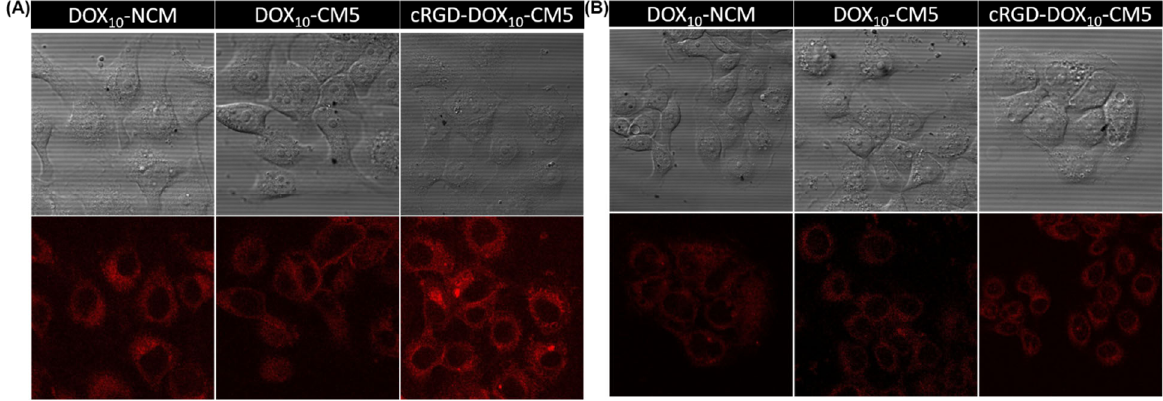
Figure 5. CLSM images of ( A ) MCF 10A cancer cells, and ( B ) MCF 10A normal cells after 2 h incubation with DOX 10 ‐ NCM, DOX 10 ‐ CM5, cRGD ‐ DOX 10 ‐ CM5.